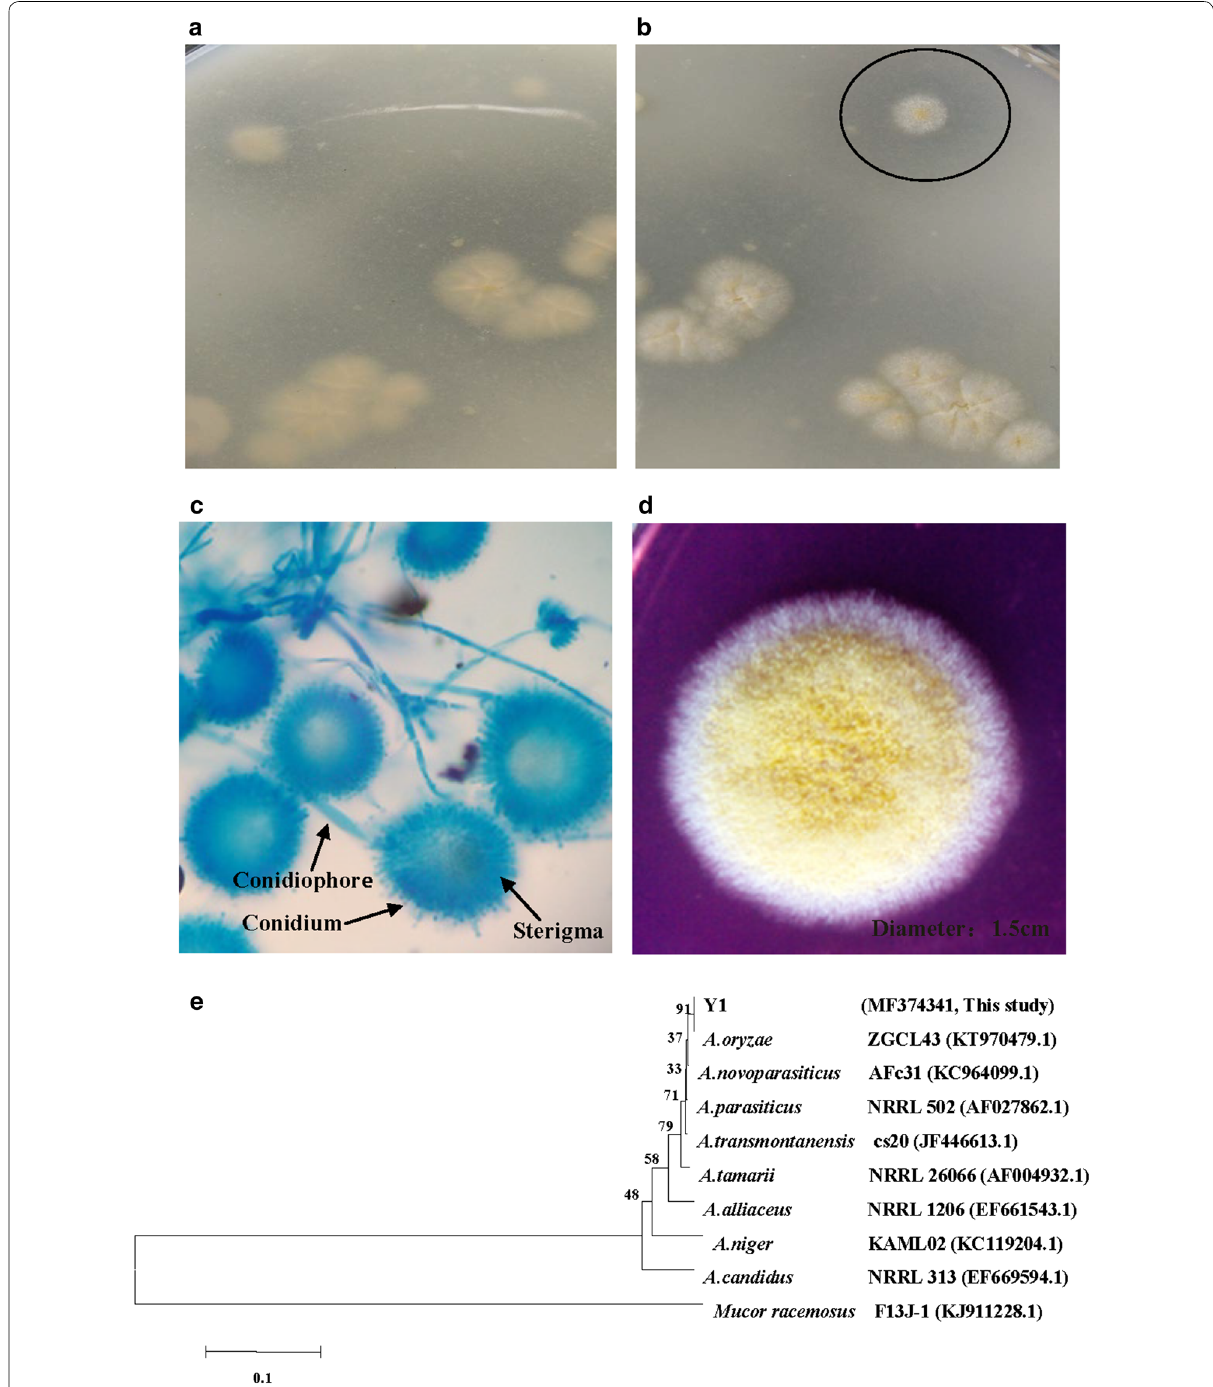
Fig. 1 The hydrolysis circle of high protease‑producing strain Y1 on the casein medium: a the back of plate; b the front of plate; c the colony morphology of strain Y1; d the results of strain Y1 by optical microscope; e phylogenetic tree showing the relationship between strain Y1 and other closely related fungi, with 0.005 substitution